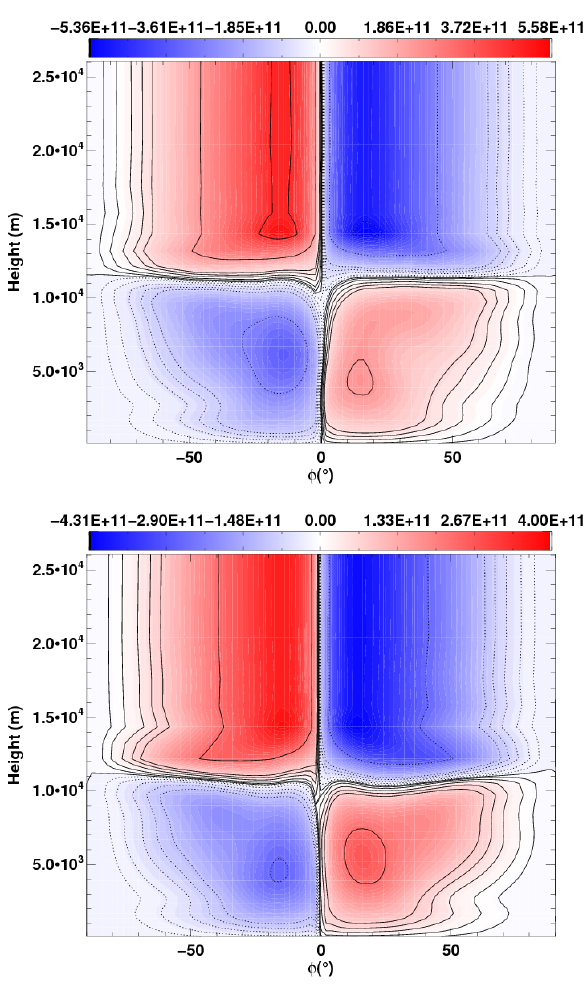
Figure 21. Figure showing, for the tidally locked Earth test (Merlis and Schneider, 2010; Heng et al., 2011b), the stream function Ψ (defined in text, see Equation 21) for the ND ( top panel ) and EG gc ( right panel ) models (see Table 2 for explanation of model types). The contours in both panels are the same and set at values − 5 . 0 × 10 11 , − 2 . 5 × 10 11 , − 1 . 0 × 10 11 , − 7 . 5 × 10 10 , − 5 . 0 × 10 10 , − 2 . 5 × 10 10 , − 1 . 0 × 10 10 , 0.0, 1 . 0 × 10 10 , 2 . 5 × 10 10 , 5 . 0 × 10 10 , 7 . 5 × 10 10 , 1 . 0 × 10 11 , 2 . 5 × 10 11 and 5 . 0 × 10 11 .